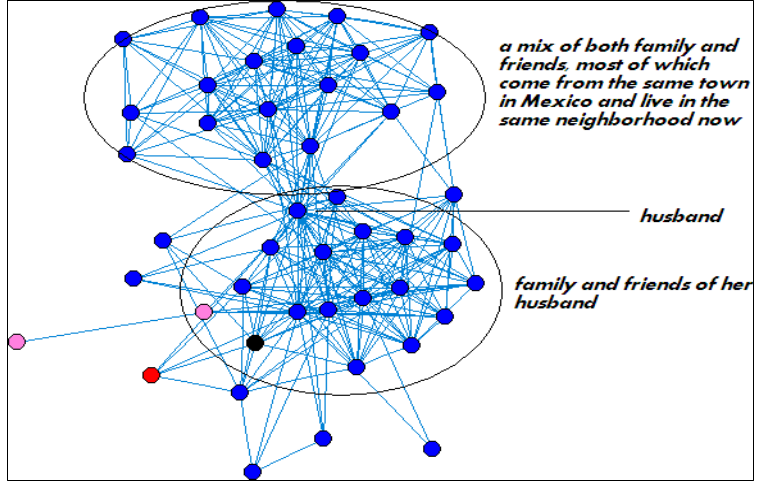
Note: Most alters in her network are Mexican (blue). In contrast to the woman whose network is seen in Figure 1, she reported using fewer ethnic identifications: Mexicana, Latina, Tlapanecos, Hispana.